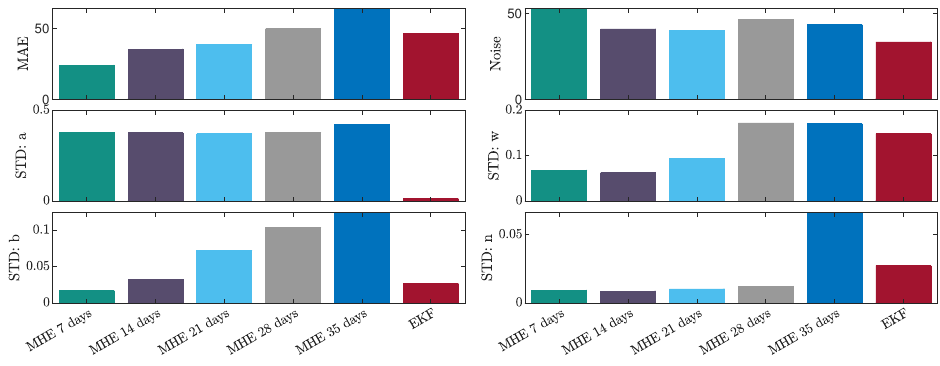
Figure 3. Comparison of the investigated observers.